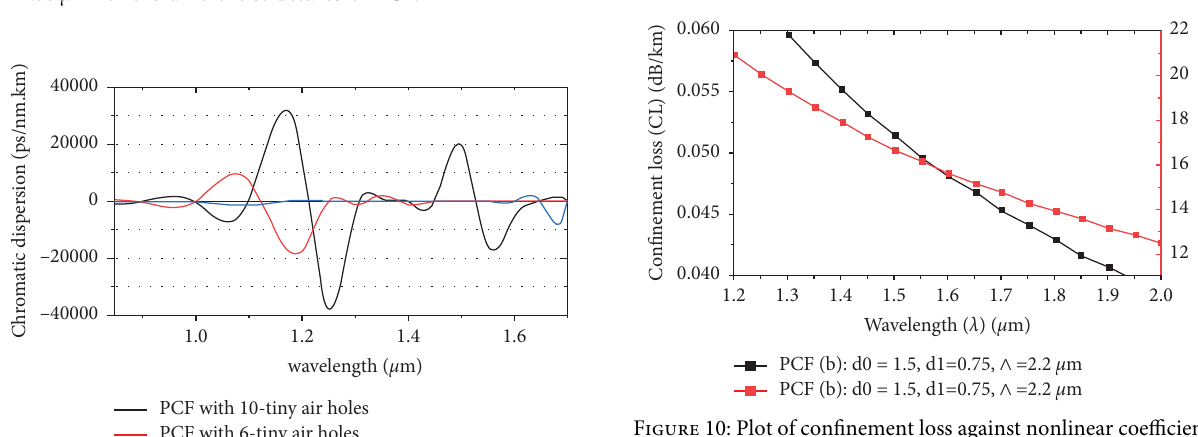
Figure 7: Chromatic dispersion, D ( λ ) as a function of the diameter ( d ) of air holes at a constant pitch of Λ � 2.2 and a wavelength of 0 λ � 1.55 μ m for the diferent structures of